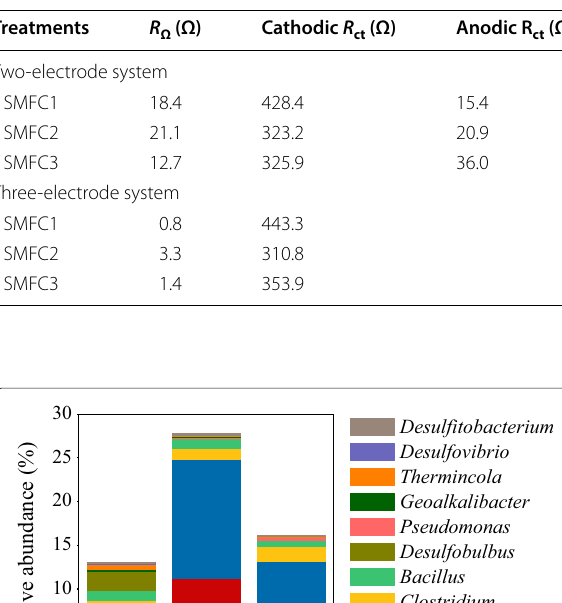
Table 1 The internal resistance of the three individual